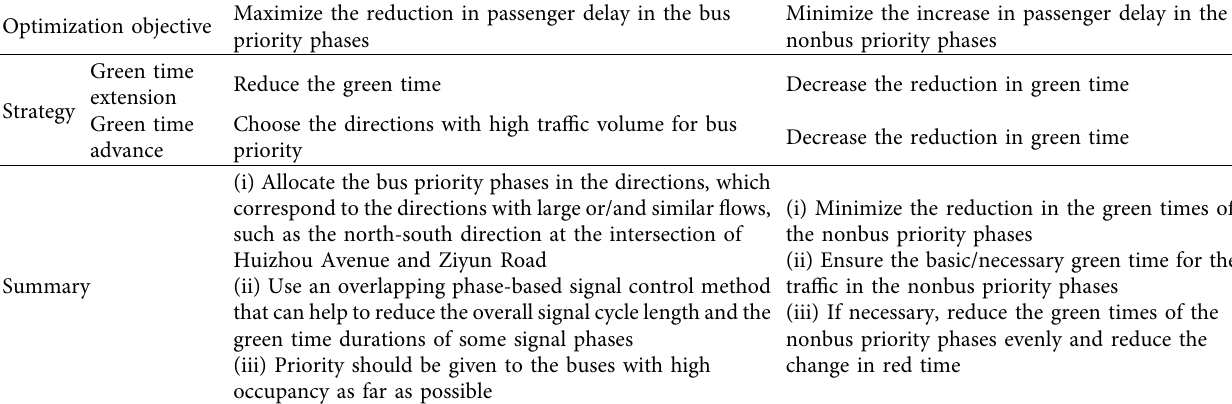
Table 4: Applicable conditions of the proposed method. Maximize the reduction in passenger delay in the bus Optimization objective priority